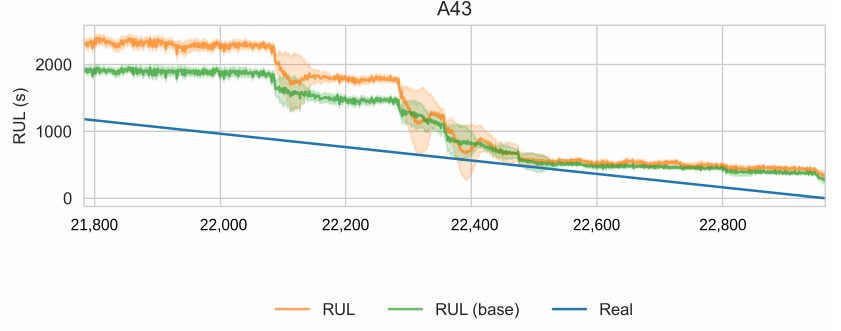
Figure 19. RUL estimation for bearing A43. Comparing the benchmark (green) and the proposed method. Intervals as the +/ − 1 running standard deviation.